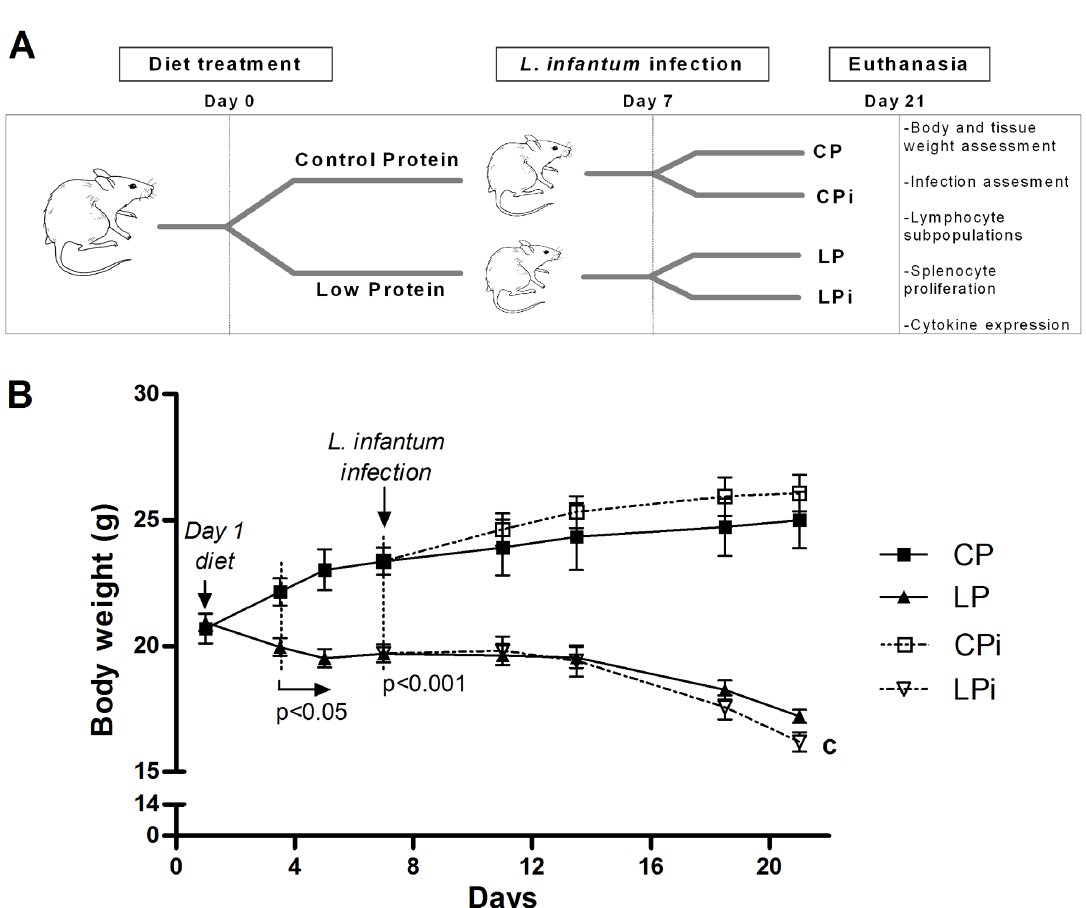
Fig. 1. Effect of protein malnutrition on body weight in mice infected with L. infantum . ( A ) Schematic representation of the experimental design. BALB/ c male mice were fed a 14% (n 5 24, CP) or 4% (n 5 24, LP) protein diet for 21 days. On day 7 of the experimental period, half the animals were infected with L. infantum and the other half received a saline solution injection. CP: animals fed 14% protein diet; LP: animals fed 4% protein diet, CPi: animals fed 14% protein diet and infected; LPi: animals fed 4% protein diet and infected. Two weeks later, the animals were sacrificed and assessed for susceptibility to infection and immunological parameters. ( B ) Body weight was registered every third or four day and expressed as average ¡ SEM; n 5 12 mice in each group. Statistical differences before the day of infection were determined by Student’s t test. After infection, a Two-way ANOVA analysis with Bonferroni pos- hoc test was used; c 5 significant interaction between diet and infection in LPi animals at day 21, p , 0.05.